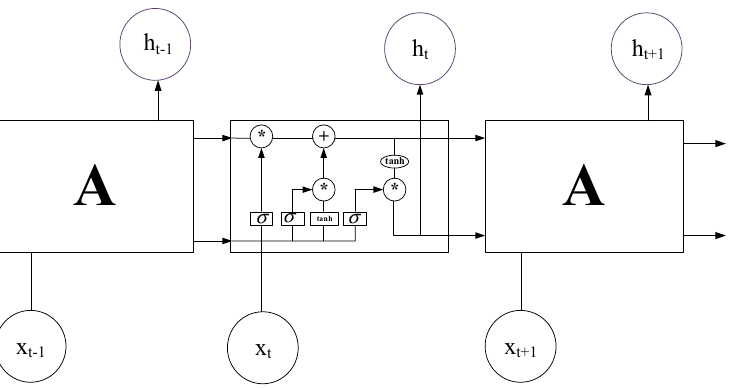
Figure 5. LSTM model. ‘*’ represents convolution operation.